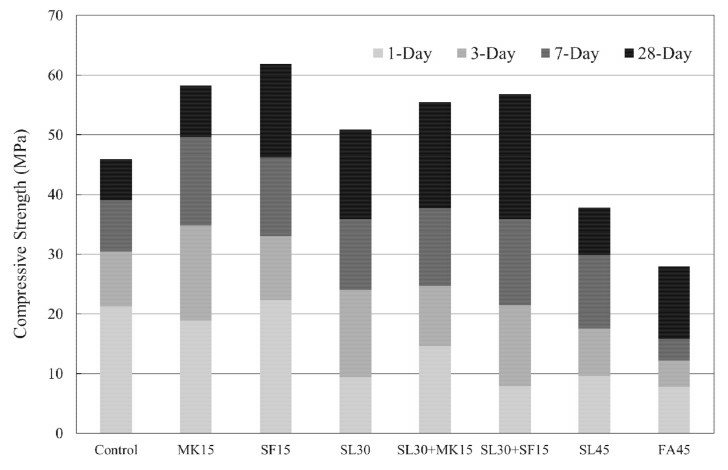
Figure 6. Compressive strength development of the 422 group